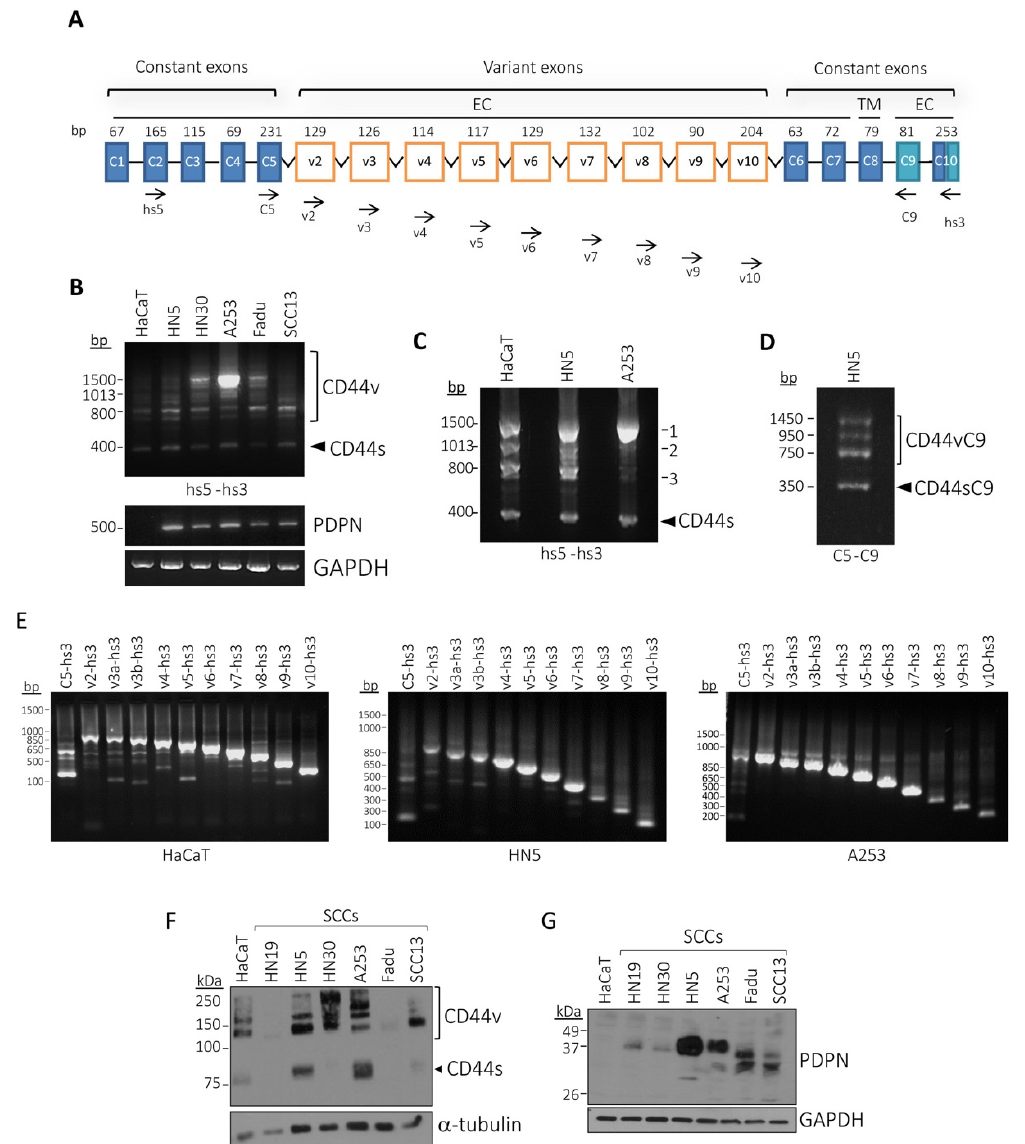
Figure 4. Podoplanin is co-expressed with CD44v and CD44s isoforms in human SCC cell lines. ( A ) Schematic representation of the human CD44 gene indicating the positions of the primers used in the RT–PCR analysis. Primer positions are indicated by arrowheads. Numbers above constant (C) and variant (v) exons indicate their size in base pairs. Exon v1 is not represented since this sequence is not expressed in human cells [47]. EC—extracellular domain; TM—transmembrane domain; CT—cytosolic domain; ( B ) RT–PCR analysis of podoplanin and CD44 expression in the indicated cell lines. The pair of primers hs5-hs3 was used for CD44. GAPDH was used as a control of RNA loading; ( C ) RT–PCR analysis of CD44 expression in the indicated cell lines using primers hs5-hs3. Three main bands of ~1500, ~1013 and ~800 bp, denoted as 1, 2 and 3, respectively were observed; ( D ) RT–PCR analysis of CD44 expression in HN5 cells using primers C5–C9; ( E ) exon-specific RT–PCR analysis of CD44 expression in the indicated cell lines. v2–v10, 5 ′ primers were used in combination with 3 ′ primer hs3. Exon v3 is covered by two primers (v3a and v3b) because of the existence of an alternative splice acceptor site in this exon [48]; ( F ) Western-blot analysis of CD44 protein expression. α -tubulin was used as a control of protein loading; ( G ) Western-blot analysis of podoplanin protein expression. GAPDH was used as a control of protein loading. Data represent three independent experiments.